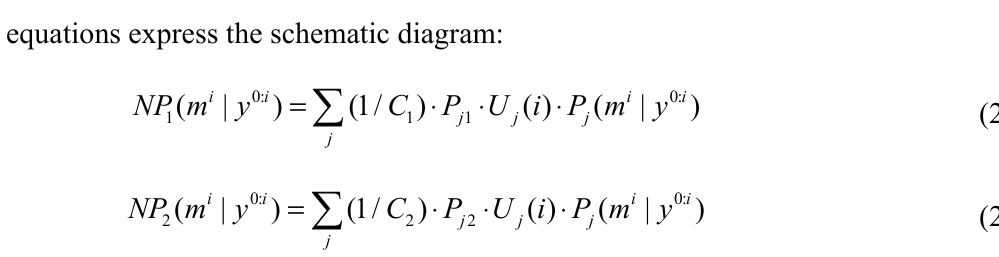
Figure 11. Updating of